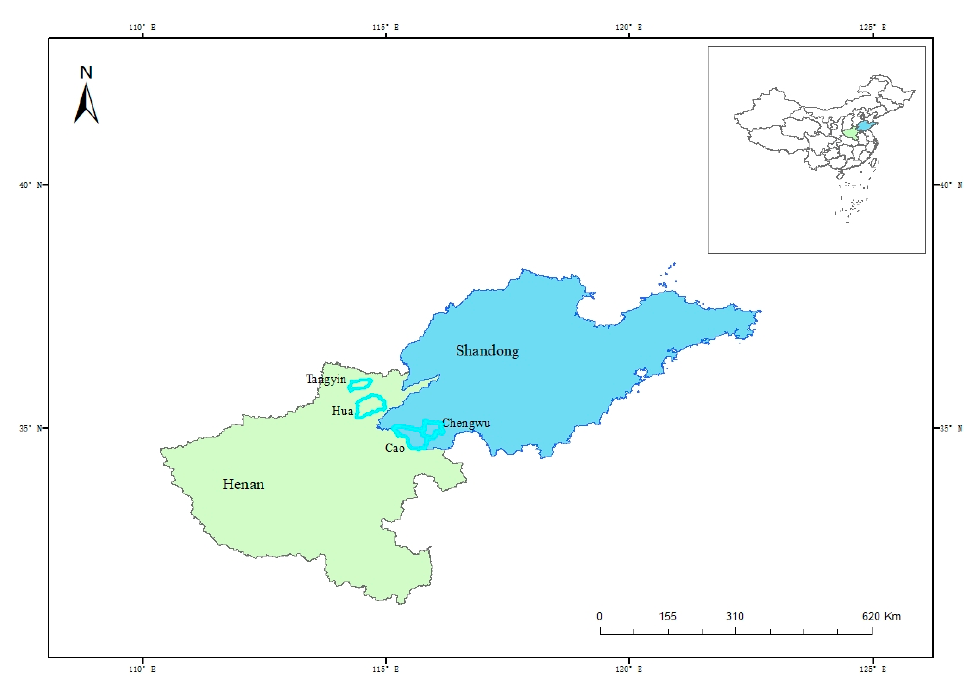
Figure 2. Maps of the study sites.